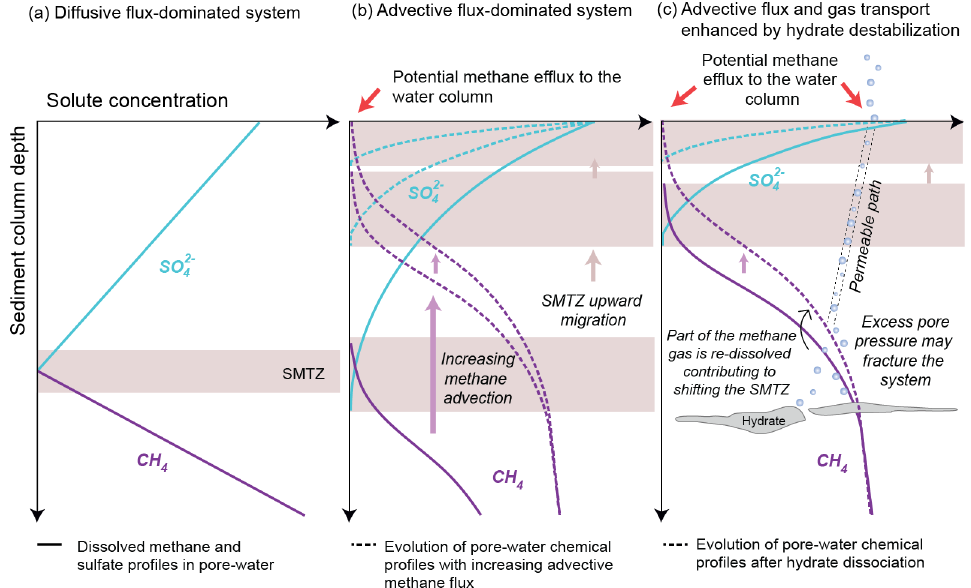
Figure 6. Conceptual representation of sulfate ( SO 2 − ) and methane ( CH 4 ) fate within the sediment 4 column at ( a ) diffusive and ( b , c ) advective flux-dominated settings. Note that hydrate dissociation favours methane pore-water over-saturation and therefore gas occurrence and potential sediment fracturing. Adapted from